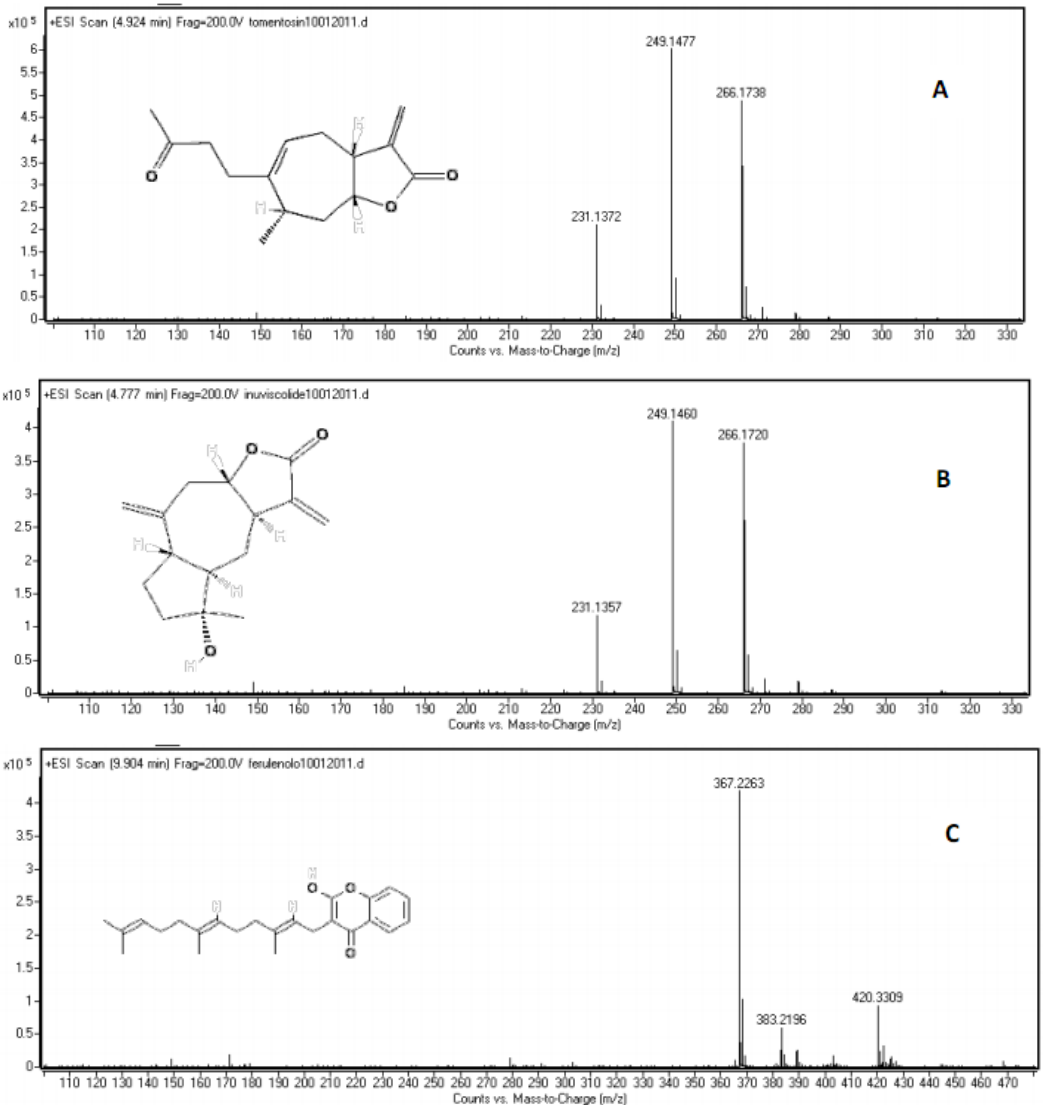
) detected in HPLC-DAD analysis and the max